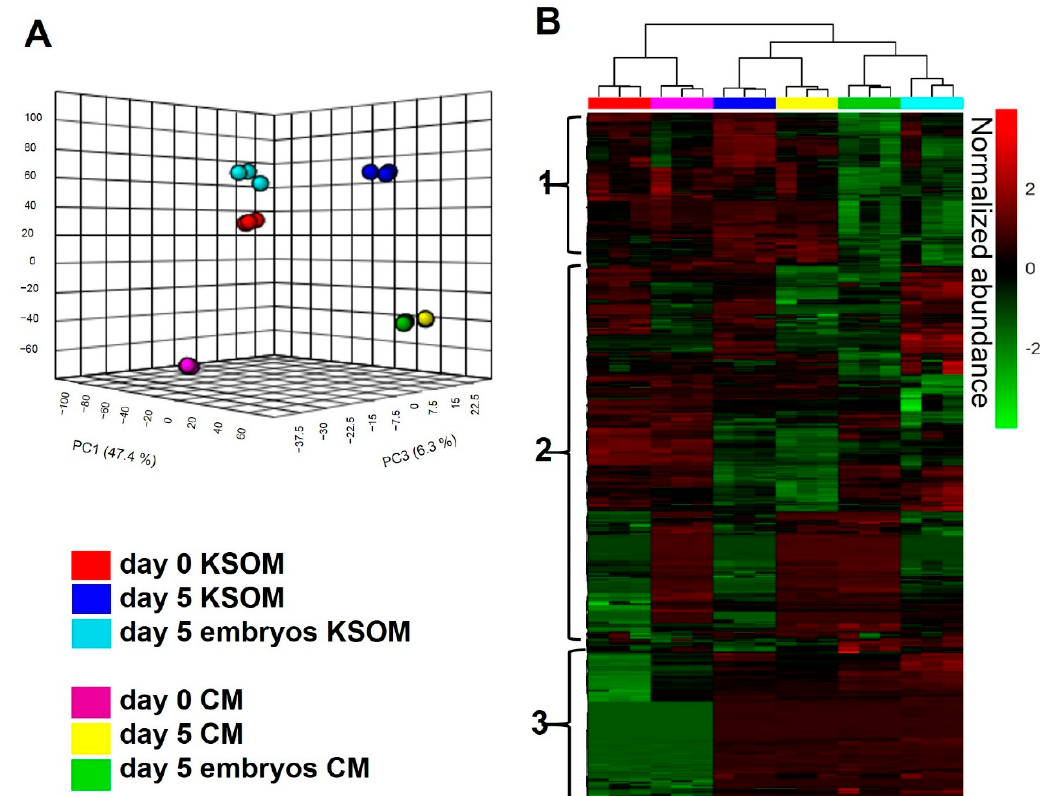
Figure 3. The metabolite composition of the media used for embryo culture is considerably changed by uterine epithelial cells. LC-MS/MS global metabolomic profile analysis of blastocysts cultured in KSOM or CM in devices. ( A ) PCA plot for LC-MS/MS data of medium samples collected from devices in different experimental conditions ( n = 3 for each group): spent KSOM (blue) or CM (yellow) from devices without embryos, spent KSOM (cyan) or CM (green) from devices with embryos and the relative controls. ( B ) Heatmap representing LC-MS/MS data. Compounds are presented as rows and sample replicates as columns and processed by using Euclidean distance and Ward clustering via Metaboanalyst 4.0 for Pareto scaled, log transformed, and averaged group data. Colours are displayed by normalized abundance, ranging from low (green) to high (red).